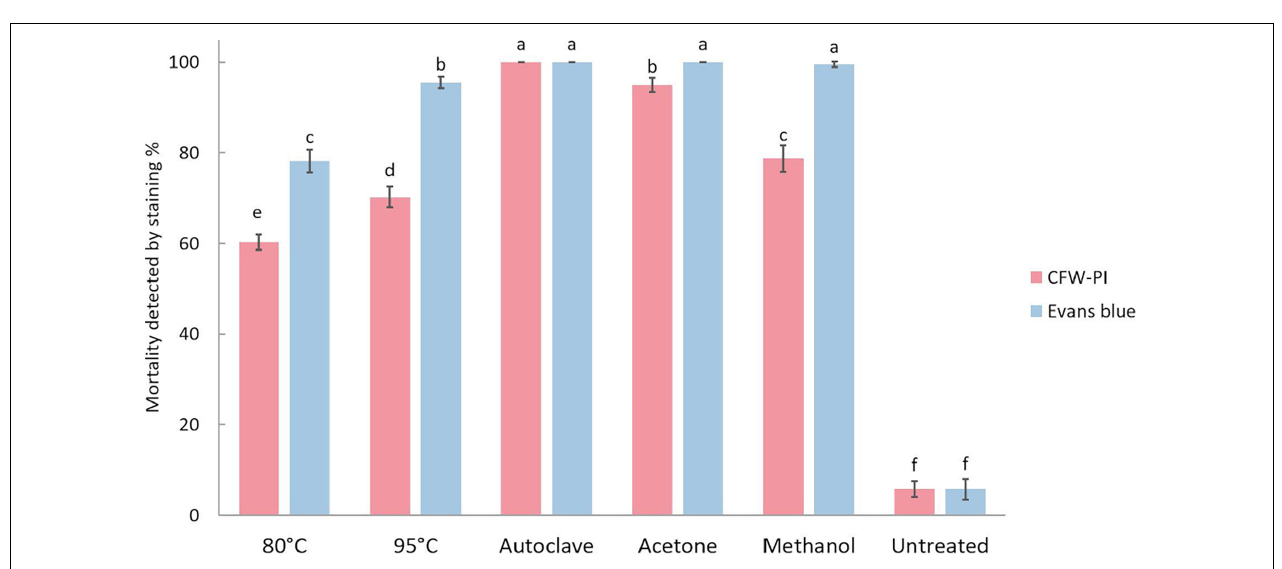
FIGURE 6 | Mortality of Plasmodiophora brassicae resting spores assessed by calcofluor white or Evans blue after different lethal treatments. Different letters indicate significant differences among the treatments (Multi-factor ANVOA, Tukey test, P < 0.05, n = 4). Error bars indicate standard